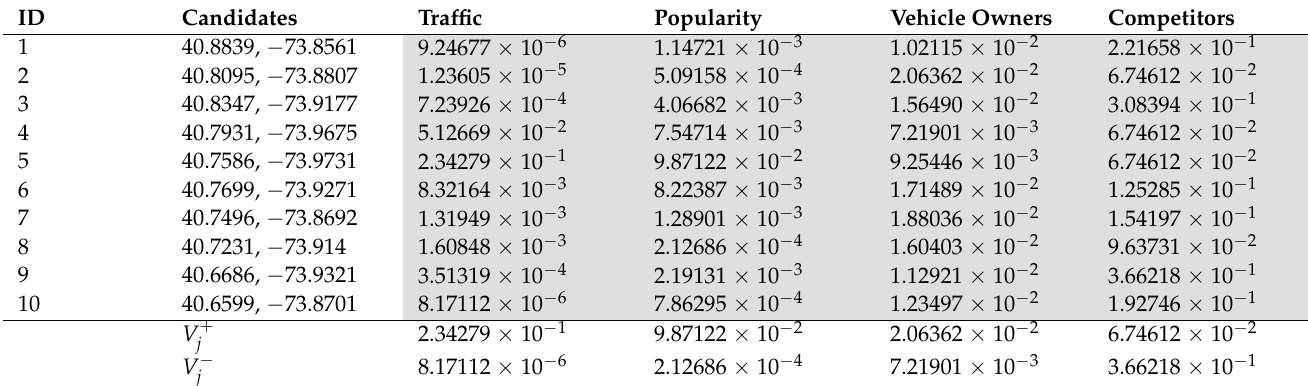
Table 5. Weighted normalized decision